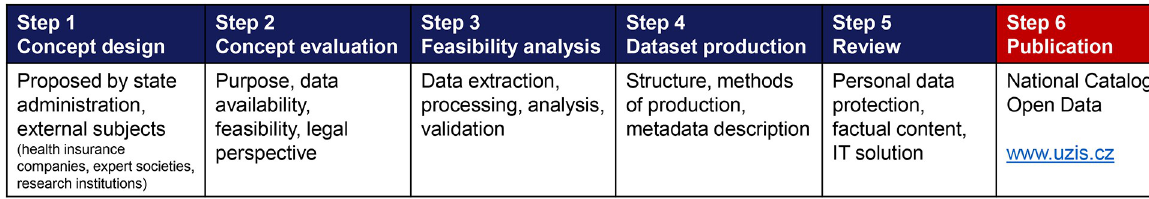
Fig 1. A chart of dataset production and